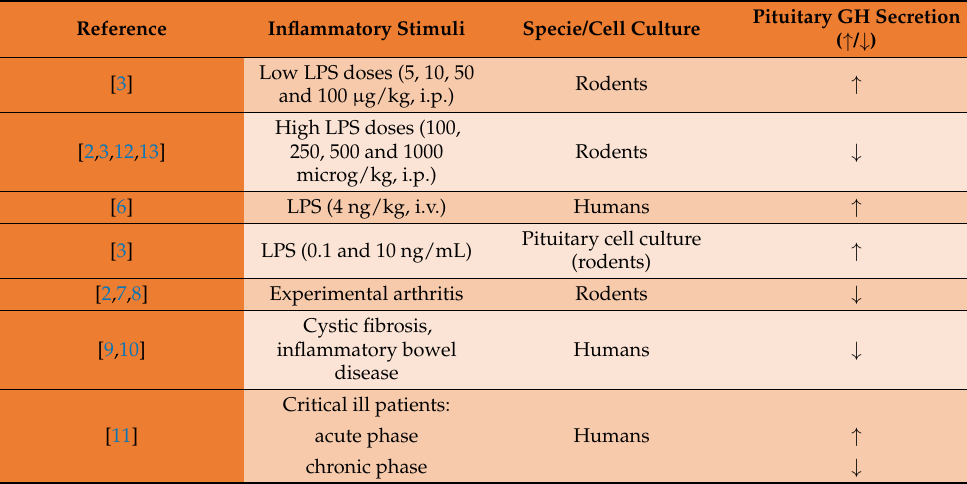
Table 1. Effect of different inflammatory stimuli on pituitary GH secretion. Upward arrows indicate increased and downward arrows decreased pituitary GH secretion in response to the inflammatory